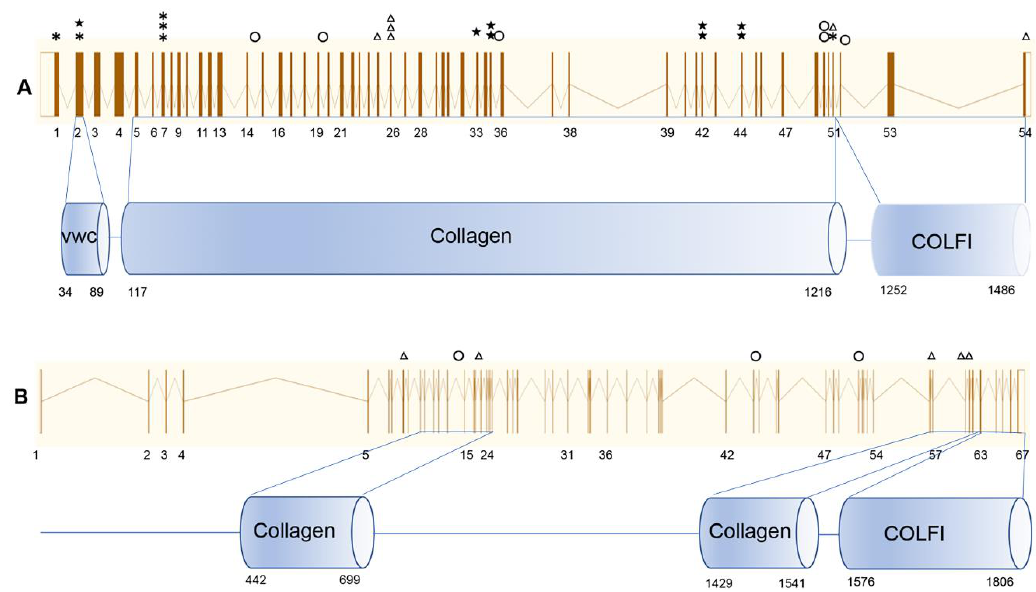
Figure 4. Distribution of COL2A1 and COL11A1 mutations. The circles indicate splicing mutations; the triangles indicate missense mutations; the asterisks indicate indel mutations; the pentagrams indicate nonsense mutations. ( A ) Mutations in COL2A1 . The upper line shows the exons of COL2A1 , and the lower line shows the domains of the COL2A1 -encoded protein. ( B ). Mutations in COL11A1 . The upper line shows the exons of COL11A1 , and the lower line shows the domains of the COL2A1 encoded protein.